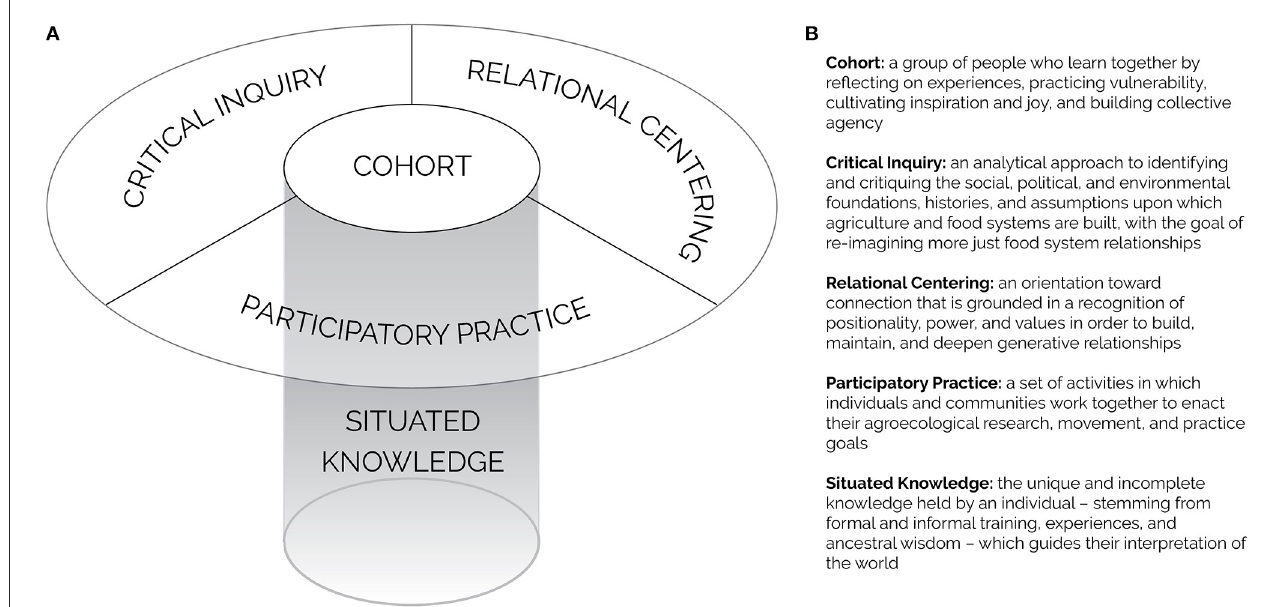
FIGURE1 Pedagogy model for graduate agro ecology learning at the University of Minnesota-Twin Cities (A) and associated definitions (B) . The learning cohort is at the heart of our model, serving as a space to synthesize critical inquiry, relational centering, and participatory practices and supported by the situated knowledges of